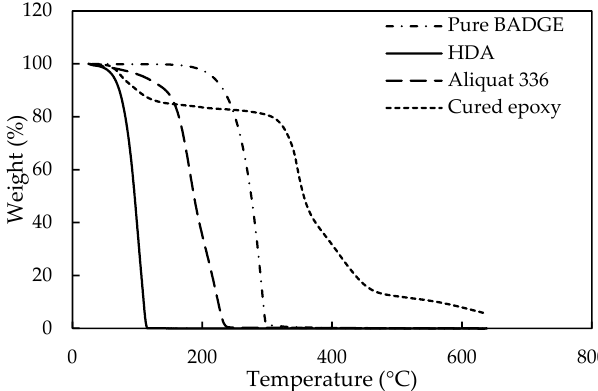
Figure 11. Thermogravimetric analysis (TGA) measurements of pure HDA (full line), pure Aliquat (striped line), pure E2 (striped/dotted line) and cured epoxy (dotted line).